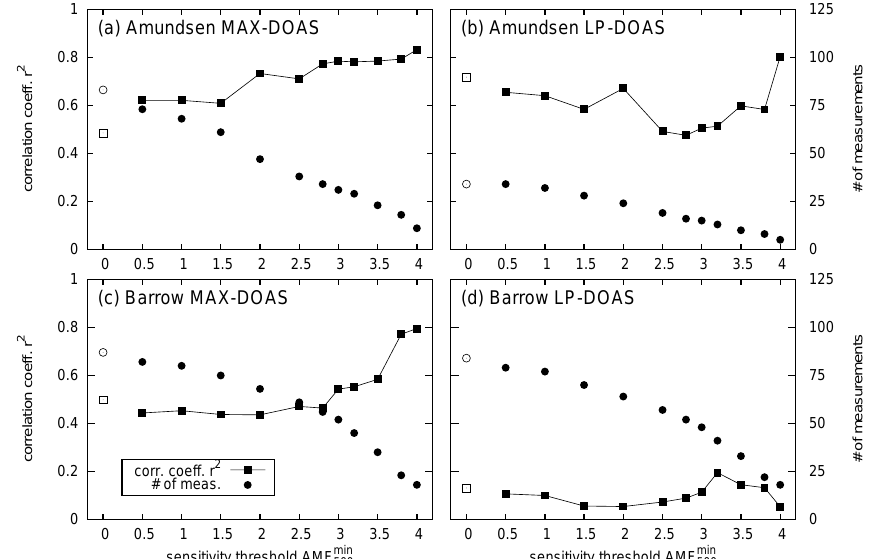
Fig. 19. Correlation coefficient r 2 and number of collocated ground-based and GOME-2 measurements depending on the applied sensitivity threshold AMF min . Empty symbols denote correlations without sensitivity filter and geometric AMF applied. 500 This indicates that the VCDs measured by GOME-2 are real- istic, and, hence, the variations of the BrO profile at Barrow were probably larger than during the Amundsen campaign where only one major event was captured by